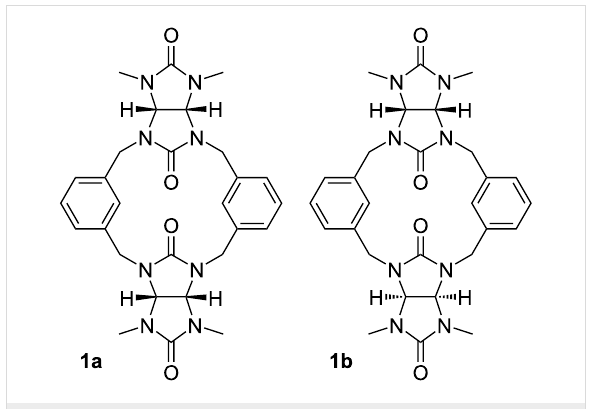
Figure 1: Molecular structures of 1a and 1b